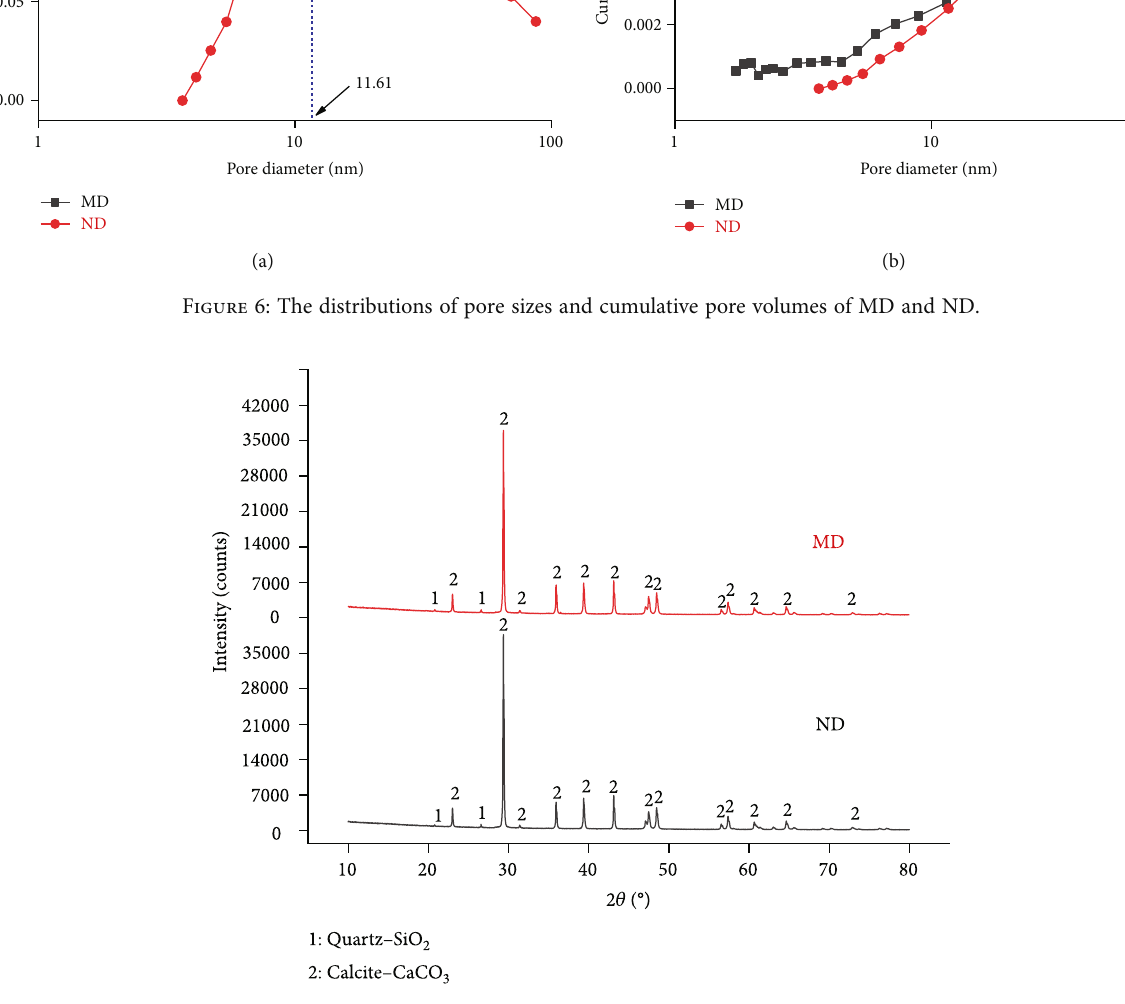
Figure 7: XRD patterns of MD and ND.